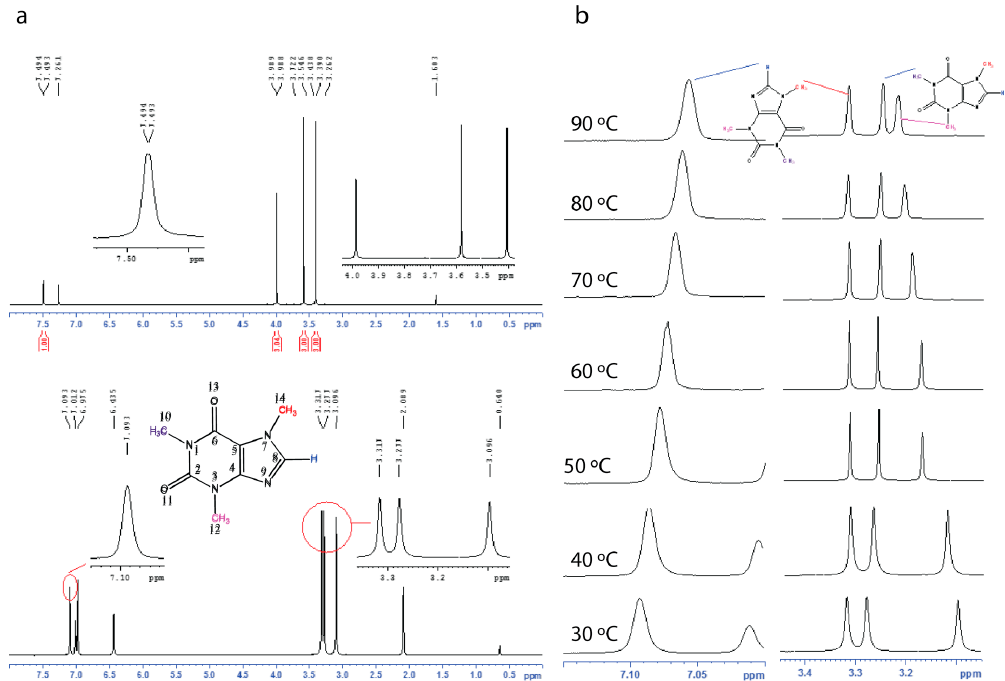
Figure 4. Solution NMR Studies; ( a ) 1 H NMR of caffeine in CDCl 3 (top) and 2.0% toluene- d 8 gel of caffeine and ( b ) variable temperature (VT) NMR of 2.0% toluene- d 8 gel of caffeine. Also see supplementary Figures S6–S8.